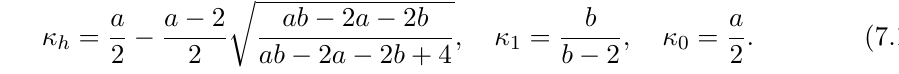
nh 1 i h 1 1 1 io ; 4 3 2 3